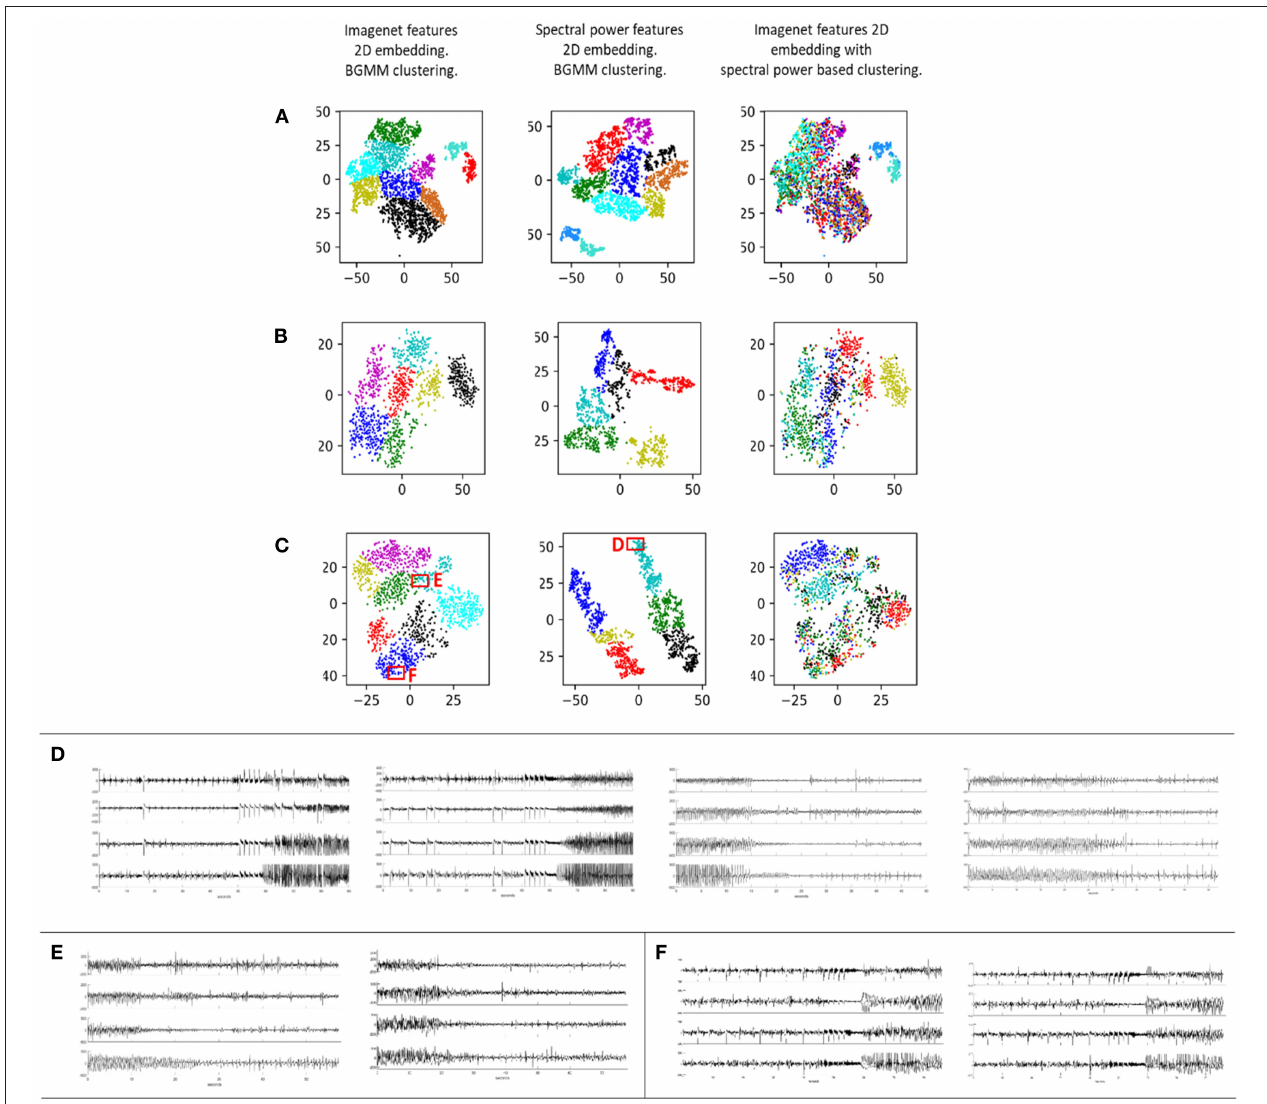
FIGURE 6 | Each row (A–C) contains iEEG records from one individual patient represented in a 2 dimensional space. Column 1: ImageNet-ResNet was used as the feature extractor. The resulting features were passed through a dimensionality reduction technique consisting of PCA followed by t-SNE. Bayesian Gaussian Mixture Models (BGMM) was then applied to find clusters in the 2-dimensional dataset. Column 2: Spectral power in seven frequency bands was extracted and these features were passed through dimensionality reduction and clustering. Column 3: Overlap between the approaches in columns 1 and 2 is demonstrated by showing the 2-dimensional representation from column 1 with cluster membership colors from column 2. (D) Examples of iEEG records clustered together in box D using the spectral power feature extraction method. These records are spectrally similar but visually different. (E,F) Example iEEG records from two clusters in boxes E and F generated using the ImageNet-ResNet feature extraction method.